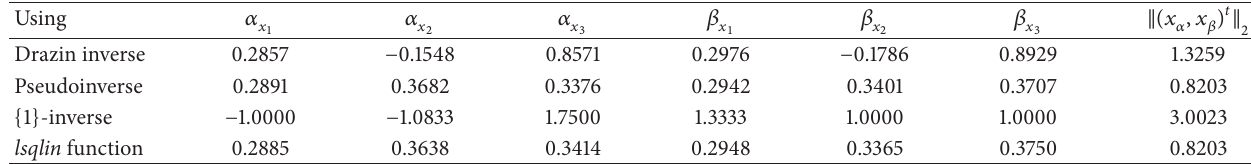
Table 6: Finding the left and right spreads.